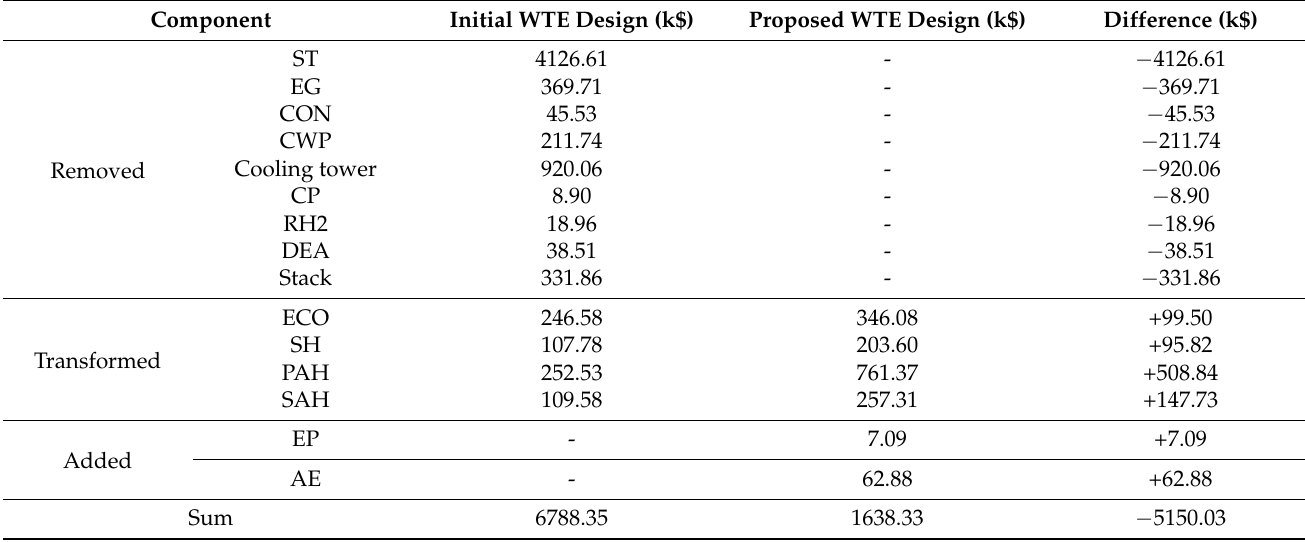
Table 19. Comparison of the investment cost between initial and proposed WTE